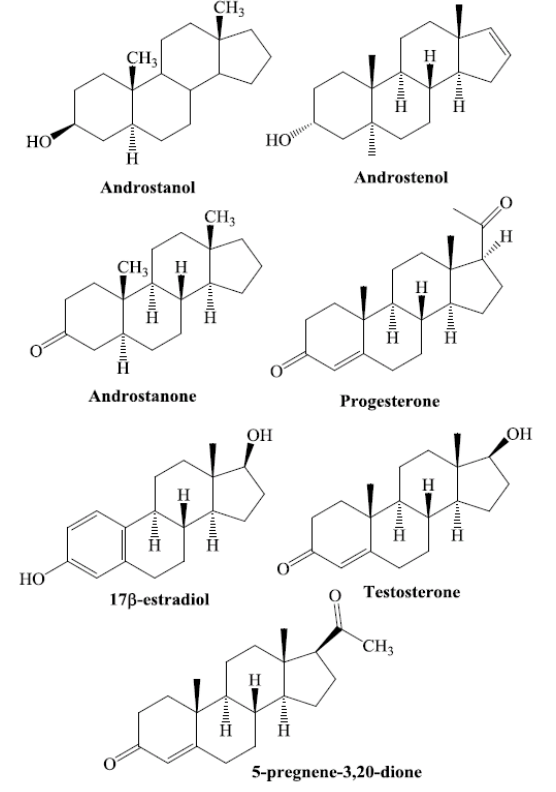
Figure 5. Chemical structures of selected steroid ligands known to activate